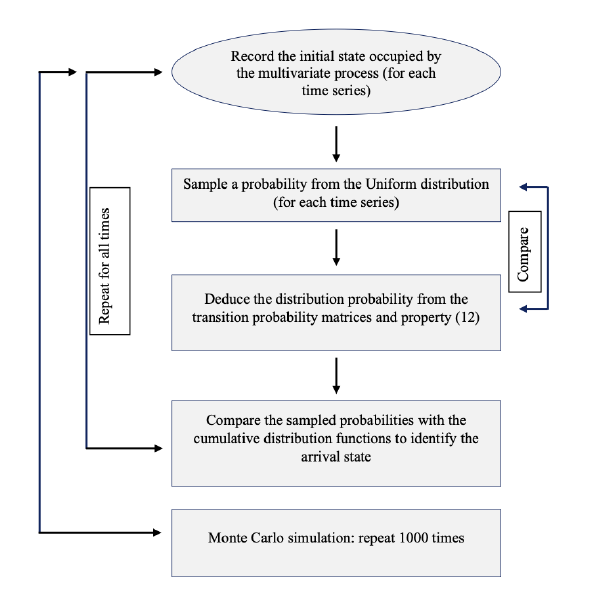
Figure 9. Algorithm for the simulation of the categorical multivariate